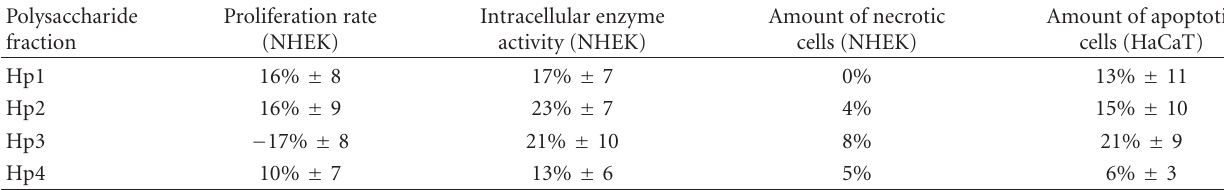
Table 3: Influence of St. John’s Wort polysaccharides on cell physiology of keratinocytes (NEHK and HaCaT). Results were normalized to the untreated cells calculated as 0%. Proliferation was determined by BrdU incorporation ELISA. MTT reduction assay was performed to investigate the intracellular enzyme activity. The cytotoxicity was determined by calculating the extracellular LDH activity compared to total LDH activity according to the manufacturer instructions. Apoptosis was measured by flow cytometry using Annexin V and 7-AAD. Polysaccharide